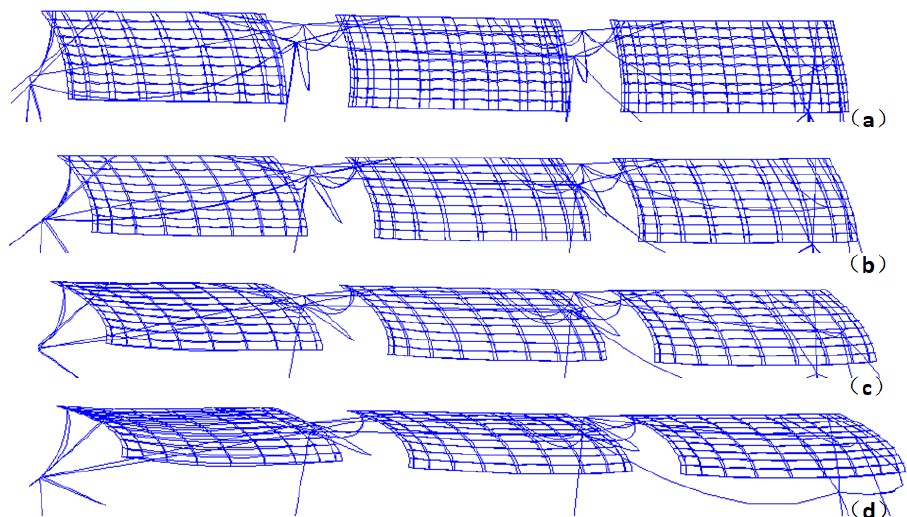
Figure 6. Deformation of fish cages under waves with a period of 10 s and a height of 1 m and different current velocities: ( a ) current velocity = 0.25 m/s, ( b ) current velocity = 0.5 m/s, ( c ) current velocity = 0.75 m/s, ( d ) current velocity = 1 m/s.